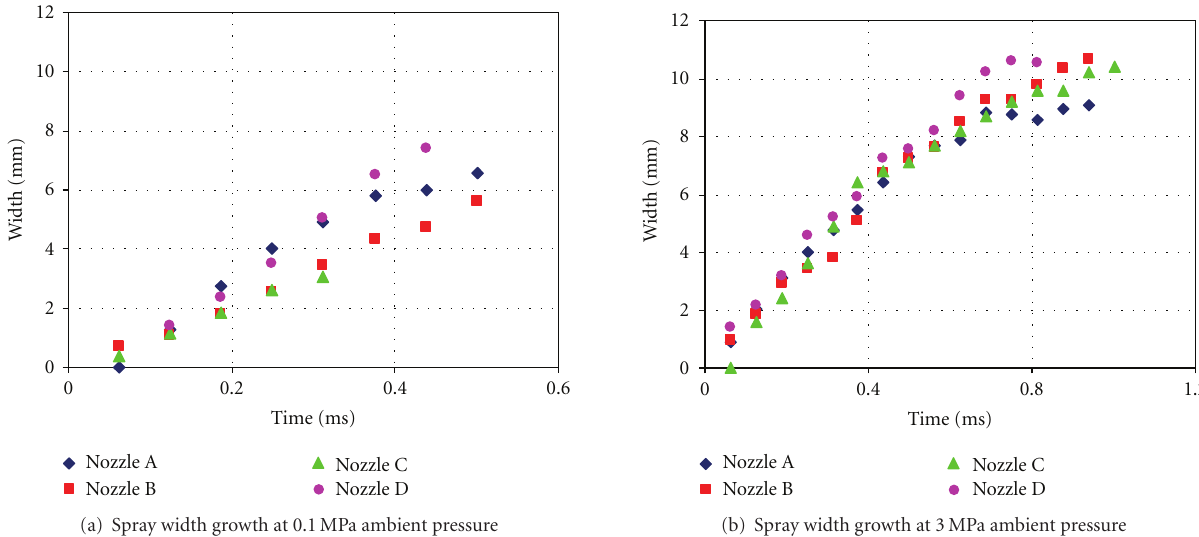
Figure 17: Comparison of spray width growth in terms of nozzle type (50MPa injection pressure, 1.5 ms injection duration).